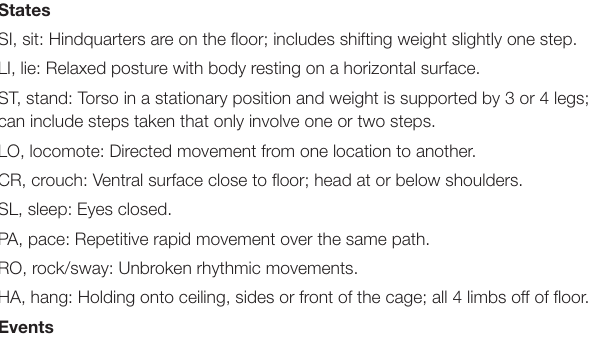
TABLE 3 | Home cage and human intruder ethogram. States